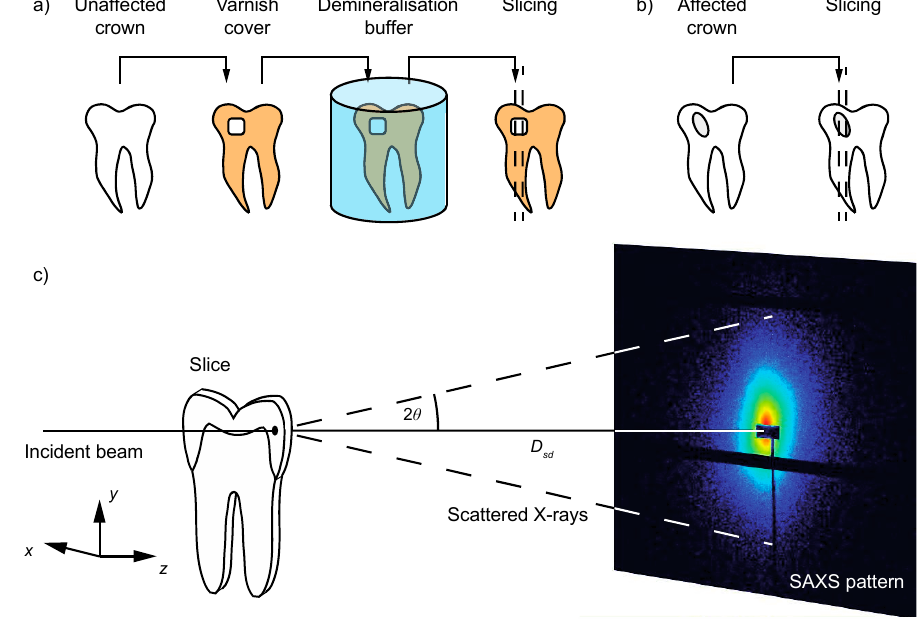
Figure 1. Sample preparation steps to obtain tooth slices with artificial ( a ) and natural ( b ) lesions and schematic representation of the spatially resolved SAXS set-up ( c ). The tooth slice is raster-scanned through the focused X-ray beam. At each position a two-dimensional scattering pattern is acquired. The direct beam transmitted by the sample is measured in intensity and absorbed by the beam stop in front of the